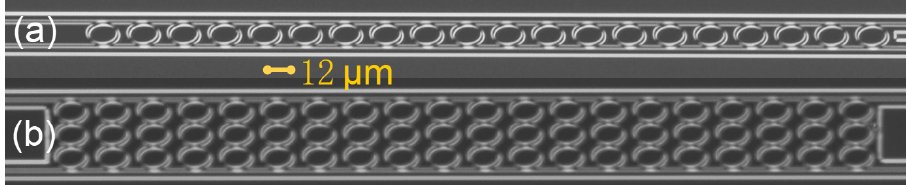
Figure 5. Optical images of the fabricated ( a ) 1 × 20 arrays and ( b ) 3 × 20